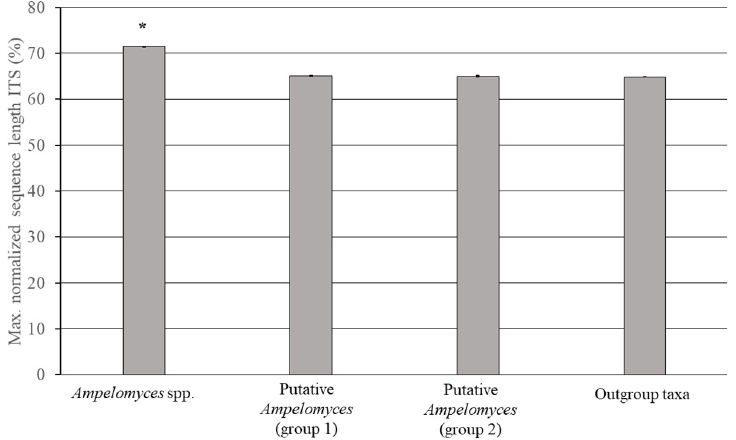
Fig 1. Normalized nrDNA ITS sequence lengths from environmental fungi are similar to those from the outgroup. The graph shows the normalized sequence length (%) of the ITS region from Ampelomyces strains (n = 376), putative Ampelomyces Groups 1 (n = 5) and 2 (n = 5) as well as the outgroup (n = 5). The normalized ITS sequence length of the Ampelomyces strains was significantly higher than those from putative Ampelomyces Groups 1 and 2 as well as from fungi belonging to the outgroup taxa, with a Kruskal-Wallis chi-squared statistic value of 53.27, a p -value of 1.59e-11 and 3 degrees of freedom. The error bars indicate the S.E.M. and the � indicates the statistical significance at the 5% confidence level.